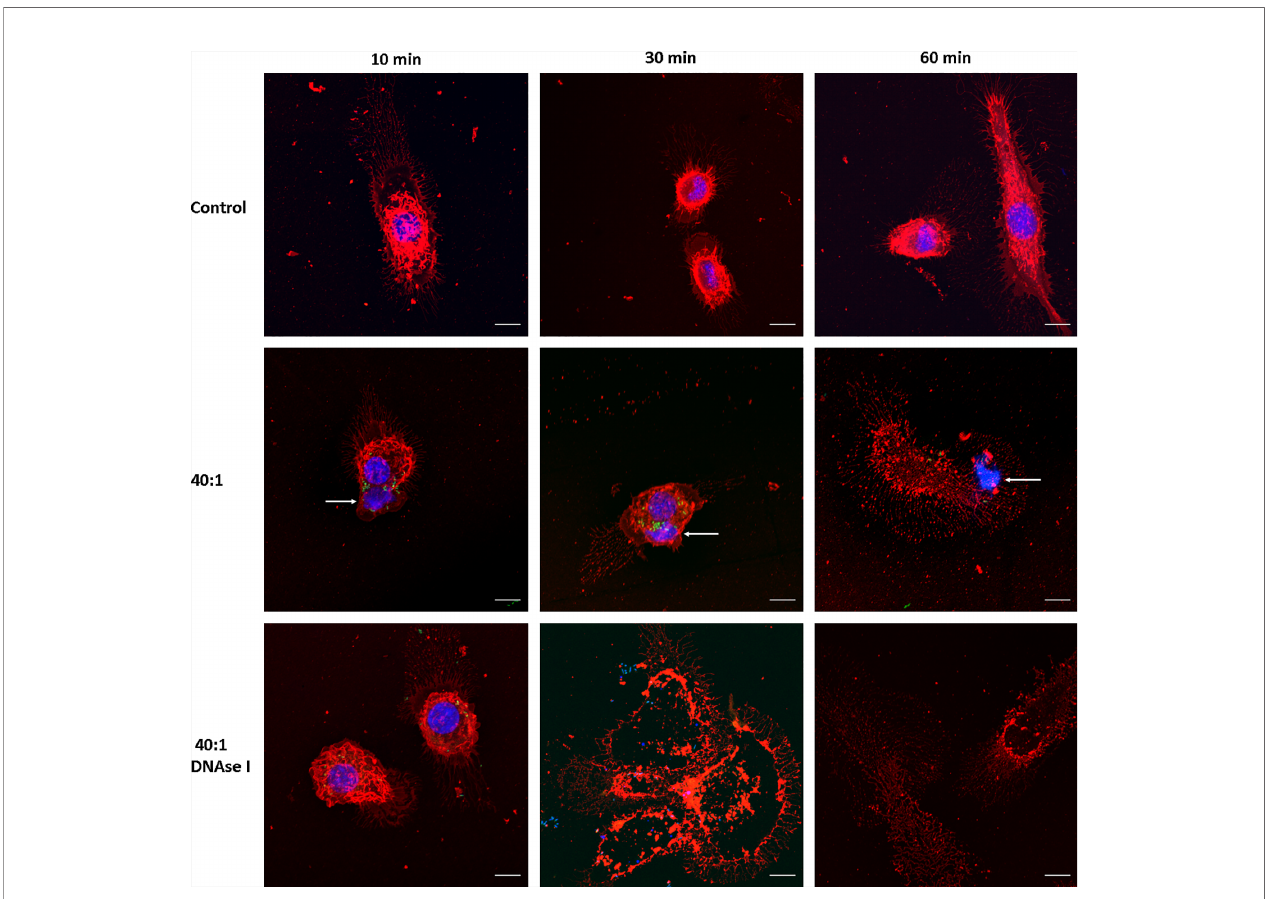
FIGURE 2 | MET release after Salmonella infection. Confocal microscopy images of J774A.1 macrophage extracellular trap release at t = 10, 30, and 60 min. Upper row: Uninfected cells (Control). Central row: Cells infected with Salmonella enterica serovar Typhimurium LVR01 (40:1). Bottom row: Cells infected with LVR01 pretreated with DNAse I. Maximum intensity z-projections are shown for membrane visualization with WGA staining (red), DNA (blue), and Salmonella (green). The arrows point out MET release. The scale bar represents 10 µm.